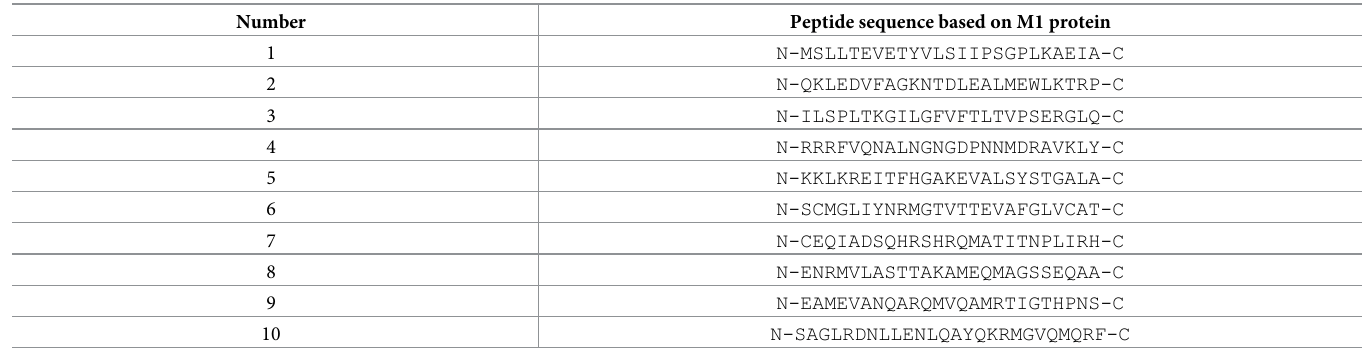
Table 1. Polypeptide sequence of the M1